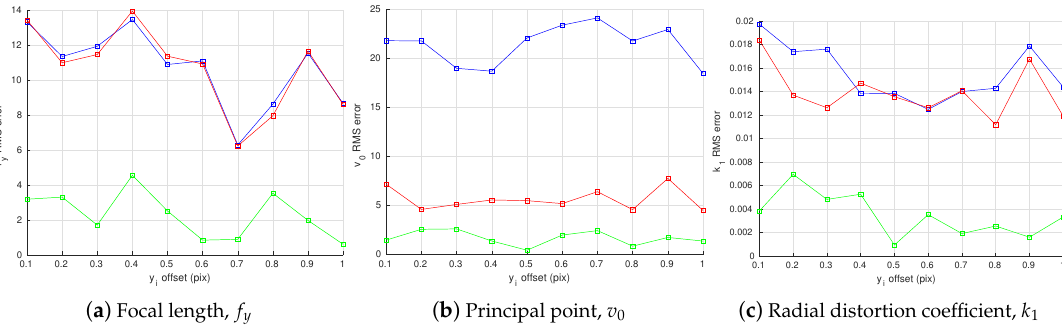
Figure 10. Root-mean-square error (RMSE) in camera intrinsic parameters w.r.t. systematic errors in estimation of camera observation y i . The blue, red, and green plots represent RMSE of the conventional method [19], the proposed method without joint optimization and the proposed method with joint optimization,